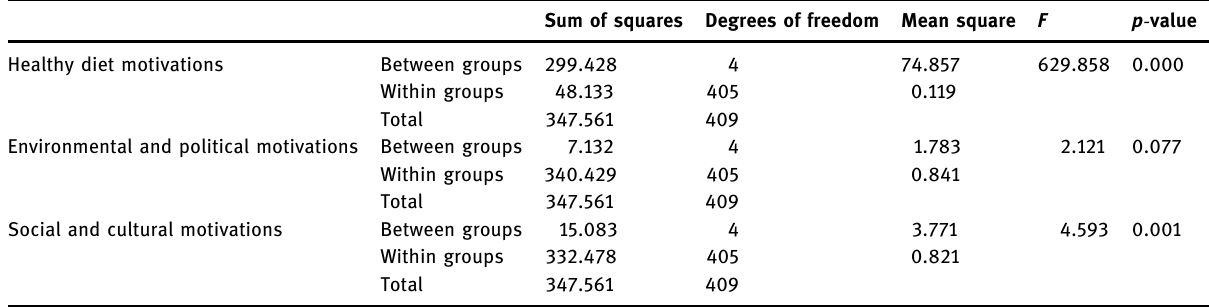
Sum of squares Degrees of freedom Mean square F p - value